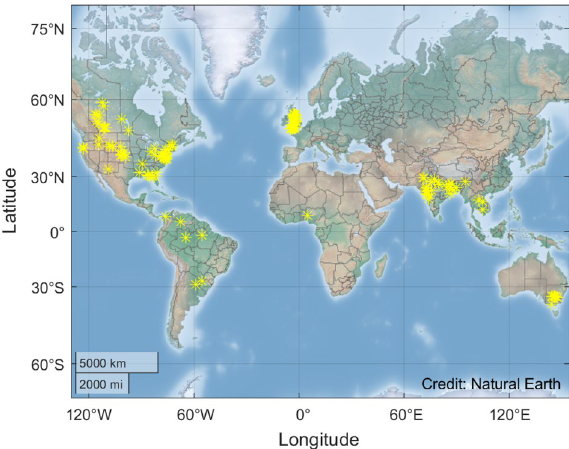
Figure 6. Locations of the investigated river sections.